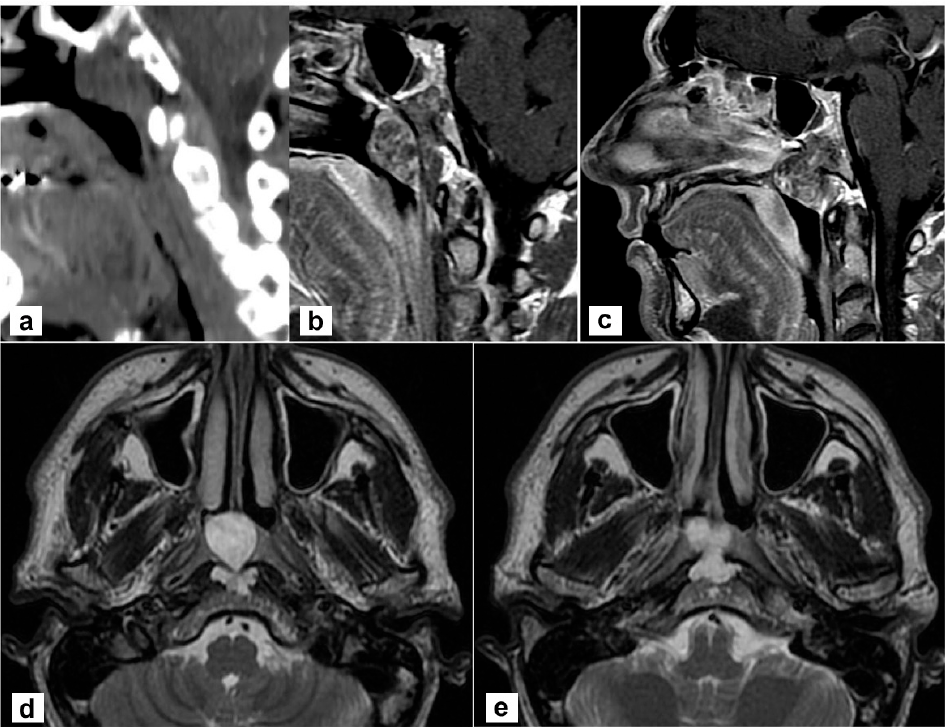
Figure 1. Radiological findings of the primary tumour. ( a , b ) Sagittal view on a paramedian plane on the left side showing the erosion of the upper portion of the lower clivus (a, computed tomography; b, T1-weighted MR sequence with contrast agent); ( c ) The lesion originates from the clivus and abutt to the clivus obstructing both choane (T1-weighted sequence with contrast); ( d , e ) the lesion is hyperintense in T2-weighted sequence; the involvement of prevertebral muscles is evident.